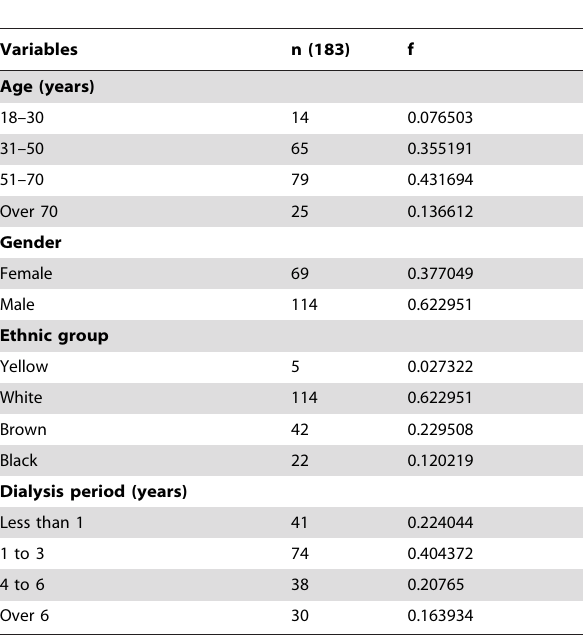
Table 1. General characteristics of CKD patients in southern